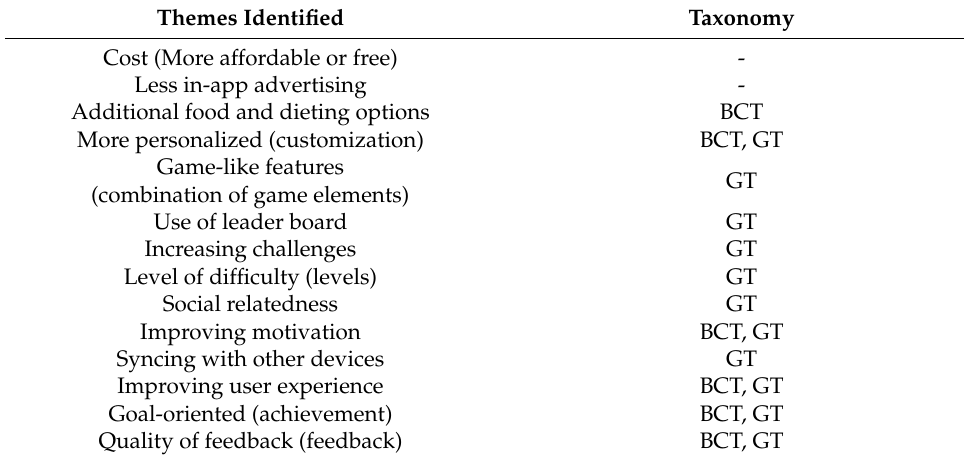
Table 4. Identified themes based on BCT and GT